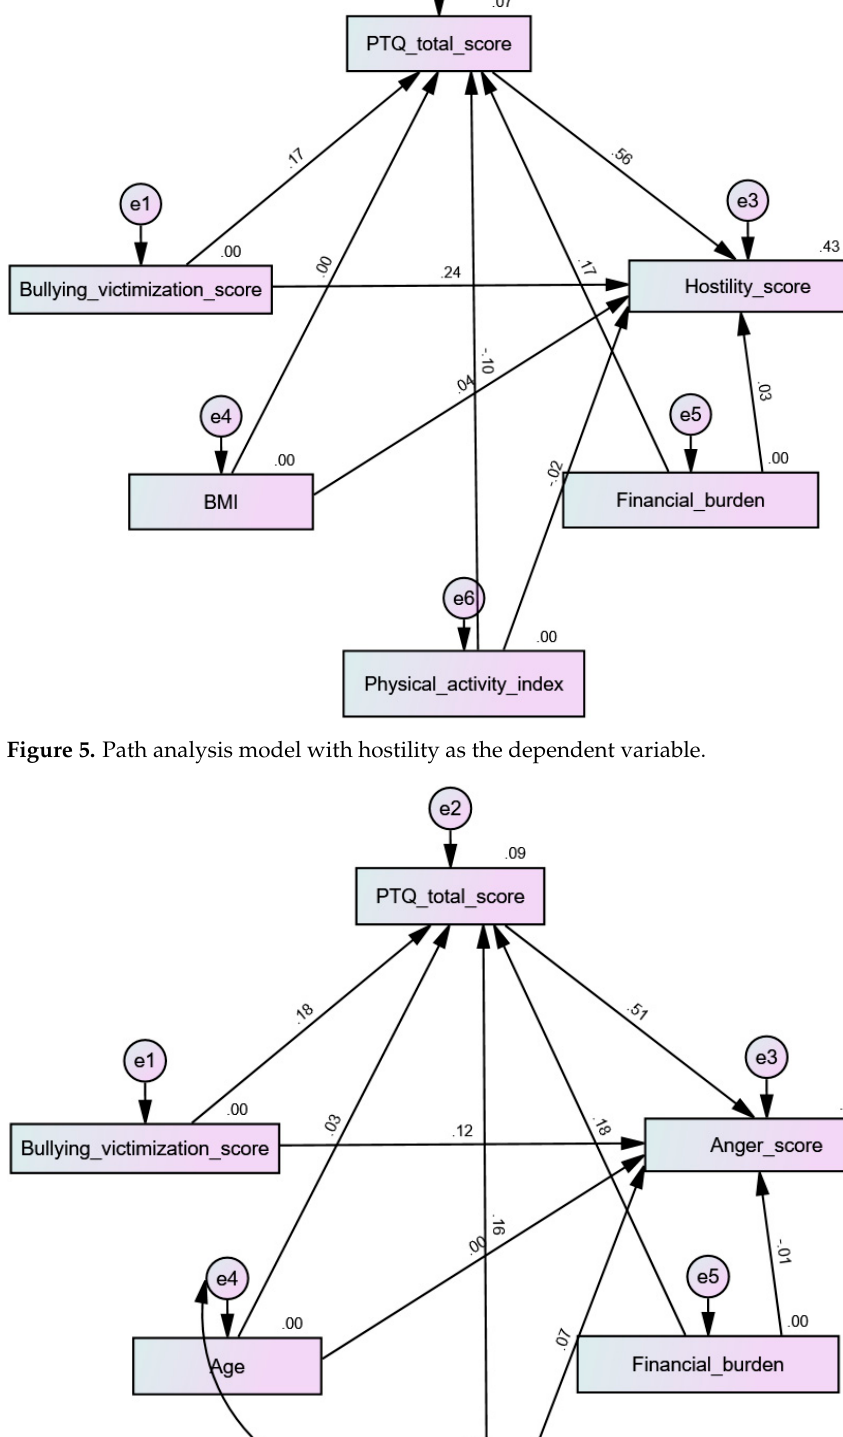
Figure 6. Path analysis model with anger as the dependent